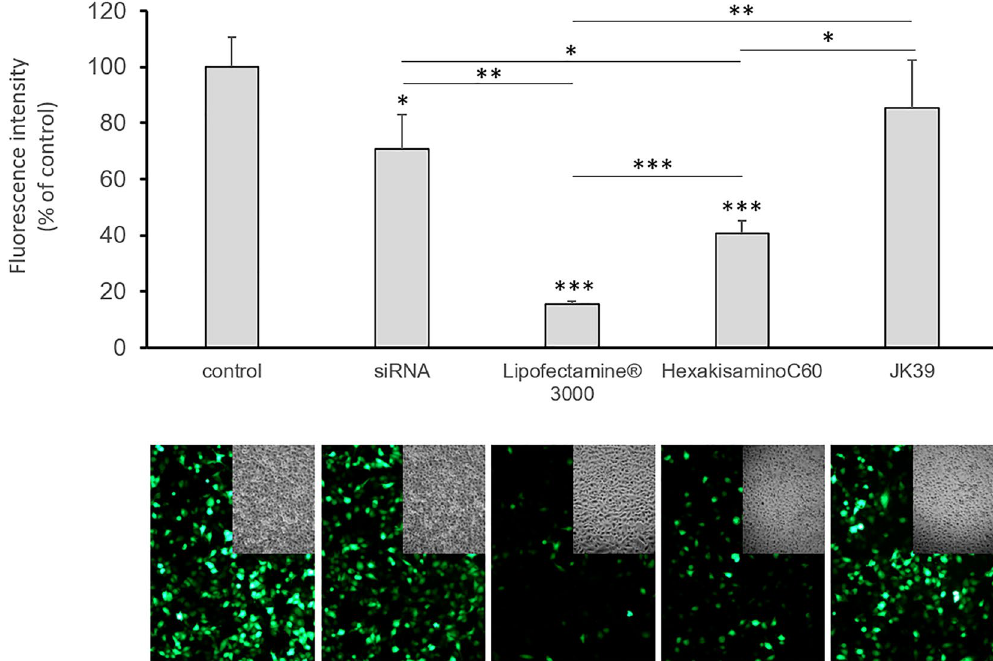
Figure 4. The efficiency of the siRNA transfer in vitro with the engineered fullerene nanomaterials HexakisaminoC 60 and JK39 and the resulting EGFP silencing in a prostate cancer model (DU145 cells that had been transfected with the plasmid encoding EGFP). Each value represents the mean ± SD (n = 3). Statistical significance was determined using the t-test (*p < 0.05; **p < 0.01; ***p <